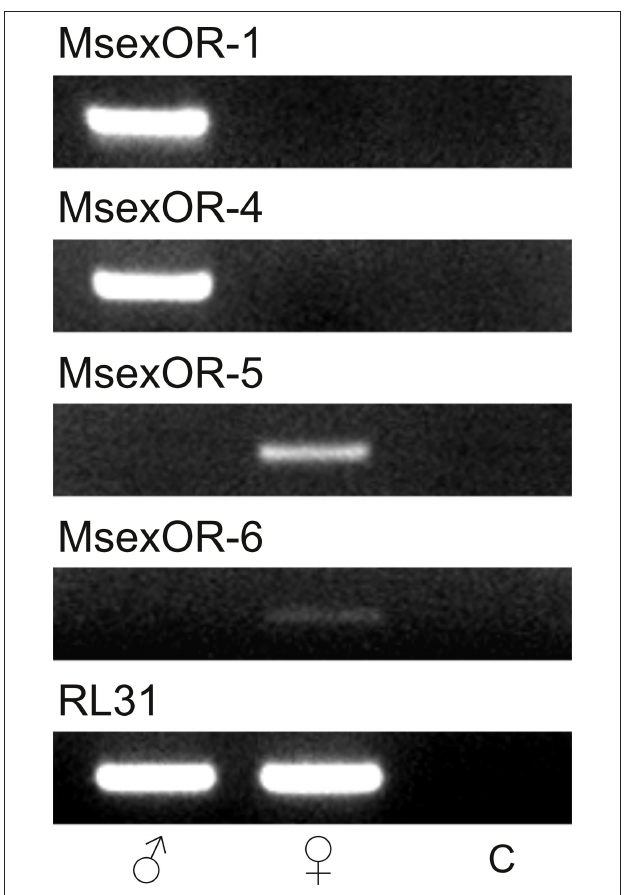
Figure 2 | Sequence relatedness of M. sexta Ors to other Lepidopteran Ors. Neighbor-joining tree based on a MUSCLE multiple sequence alignment of MsexOR-1 to MsexOR-5 (red) predicted amino acid sequences with protein sequences of B. mori (blue) and H. virescens (green) ORs. MsexOR-1 and MsexOR-4 belong to the subgroup of male-specific pheromone receptors. In addition, the group of highly conserved R2 (OR83b) receptor types (Krieger et al., 2003) is indicated. The closest homolog of MsexOR-5 is the female- specific receptor BmorOR-19; MsexOR-3 (Patch et al., 2009) is most related to BmorOR-43.